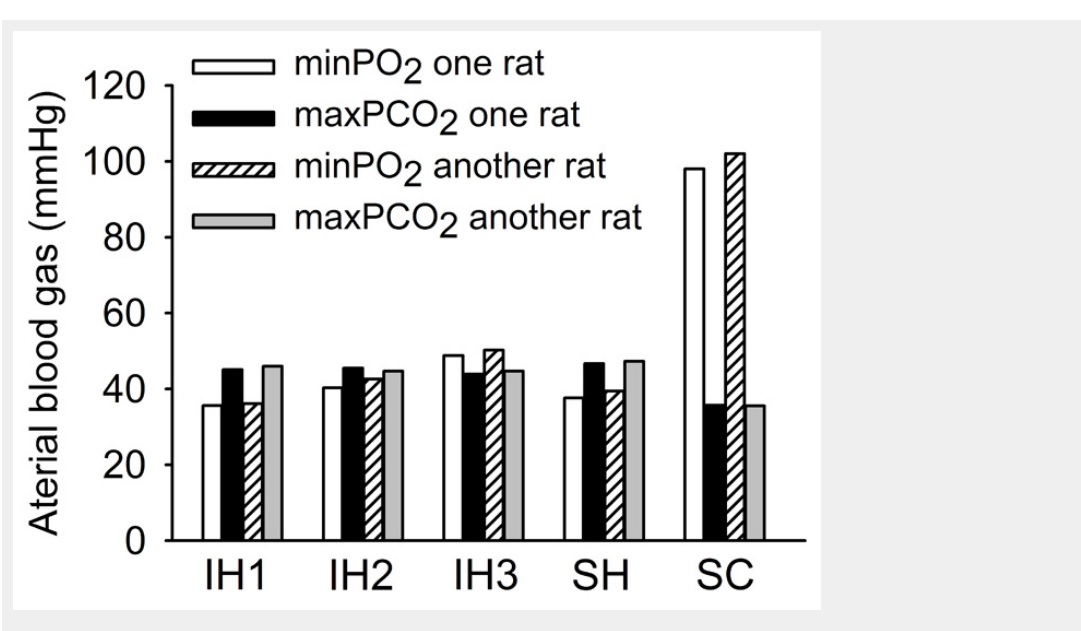
Arterial blood gas tension measured in the preliminary intermittent hypoxia experiment. Two rats were employed in each treatment group (n = 2); the measured parameters of each animal were plotted as separate bars. The minimum Po 2 levels of two animals (white and hatched bars respectively) in the IH1, IH2, and IH3 group and SH group were markedly reduced as compared to those shown in the normoxia control group. The maximum Pco 2 levels of the two rats (black and grey bars respectively) were comparable among all the treatment